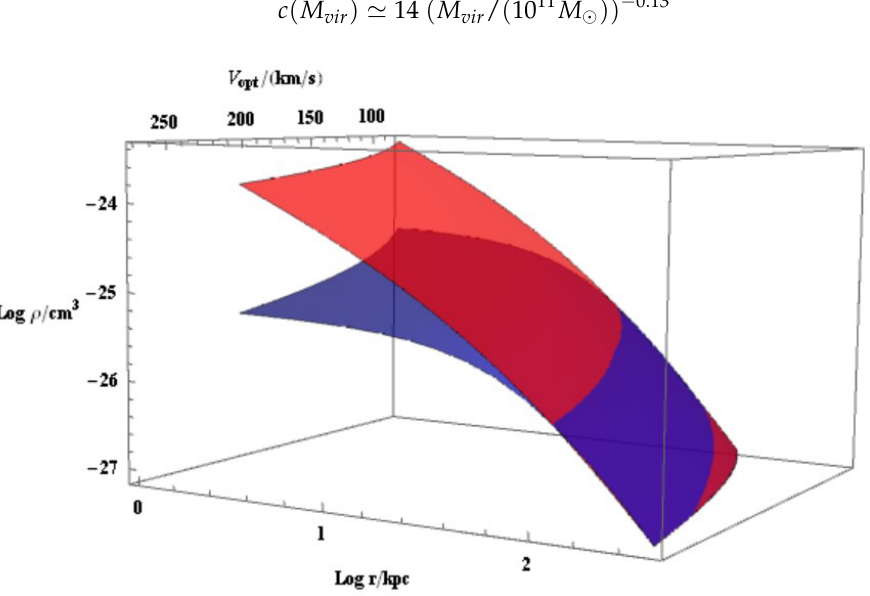
Figure 27. Primordial (red) and present (blue) DM density profiles as a function of radius r and of optical velocity V opt . Image reproduced from